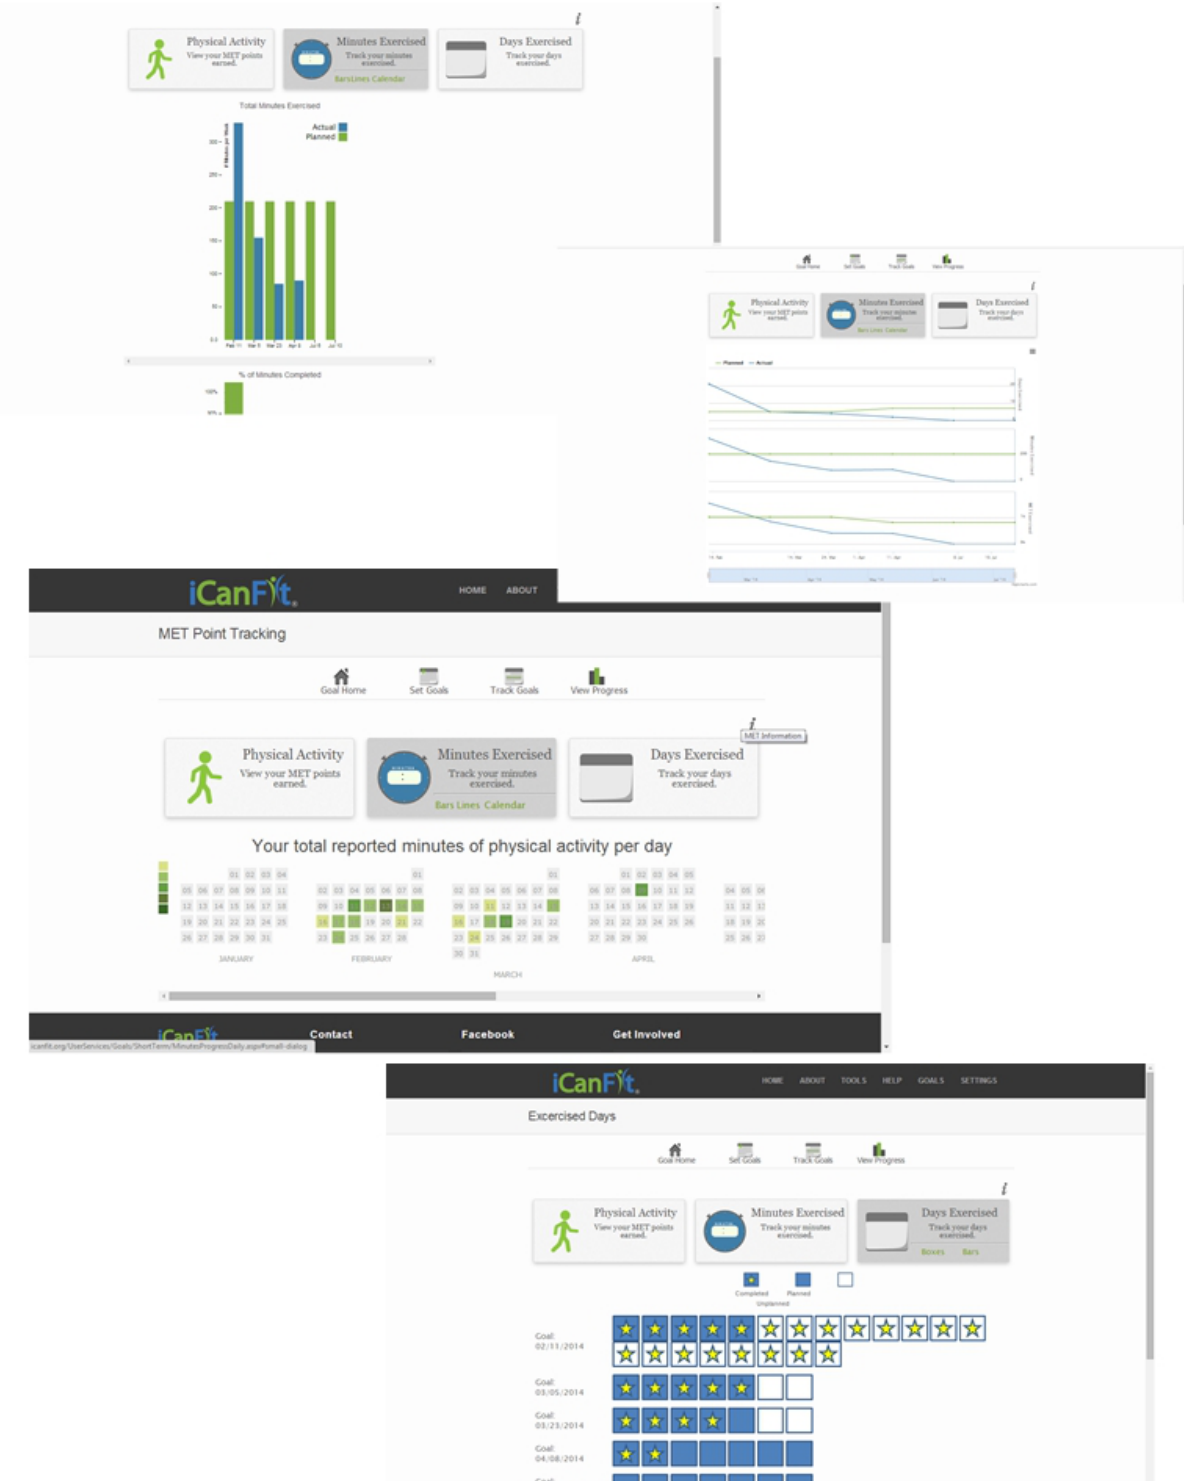
Figure 4. Different modes of View Progress on